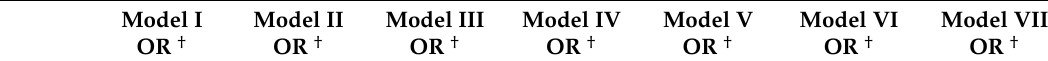
Table 6. Factors Related to KM&WM Use and Seven Diseases. (n = 11,457, Selected the KM or WM Use and including analysis